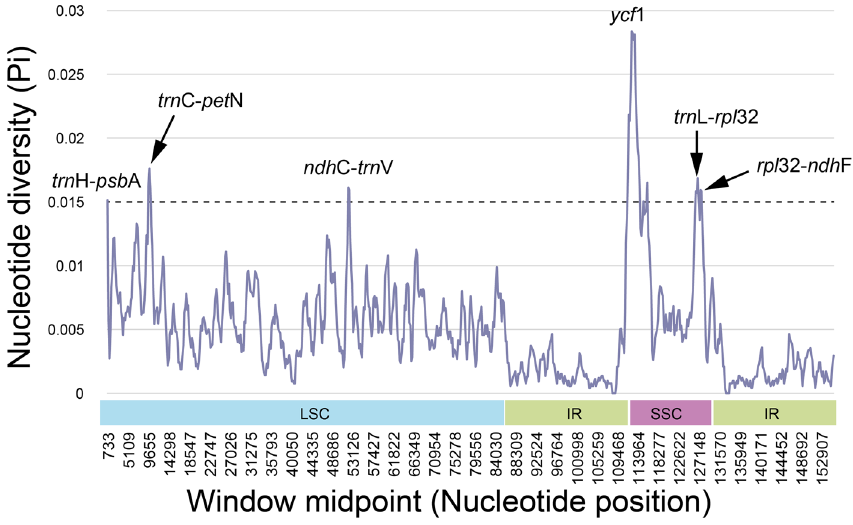
Figure 6. Six mutation hotspot regions were observed in eight Reichardia plastomes and two Launaea plastomes.